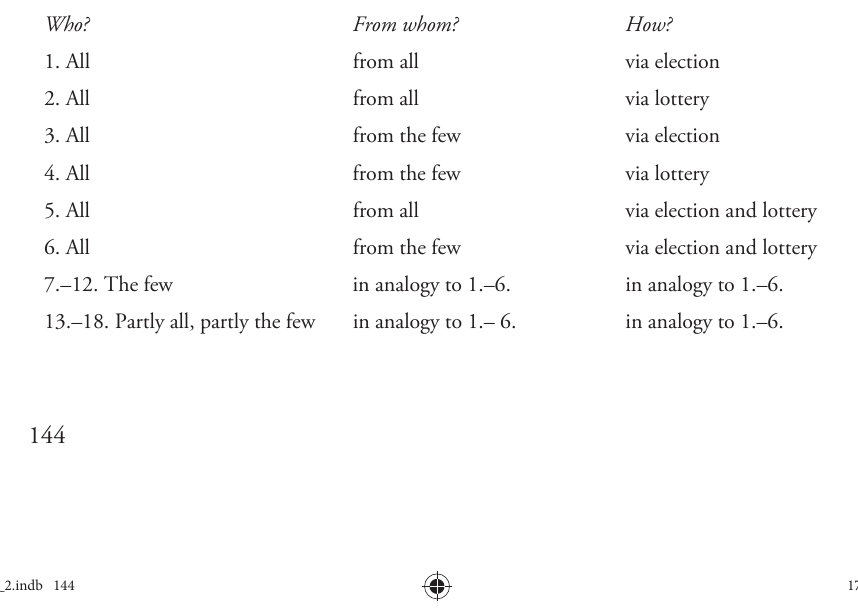
Table 1. Th e modalities for fi lling political offi ces in Aristotle’s “Th e